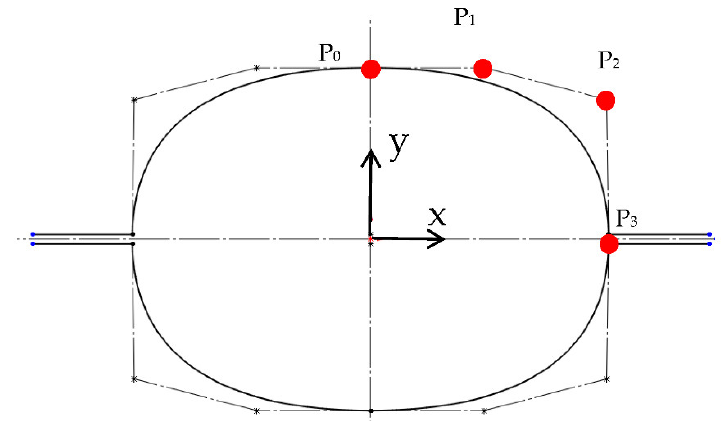
Figure 2. Bézier curve groove-shape design and the control points layout.